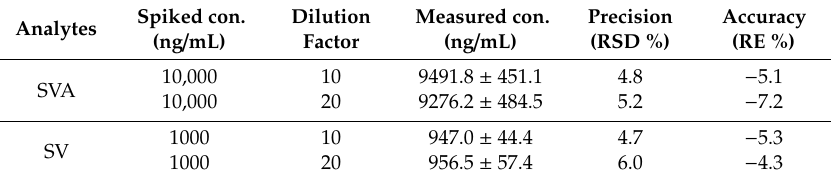
Table 4. Dilution integrity of SVA and SV in rat plasma (mean ± SD, n = 5).